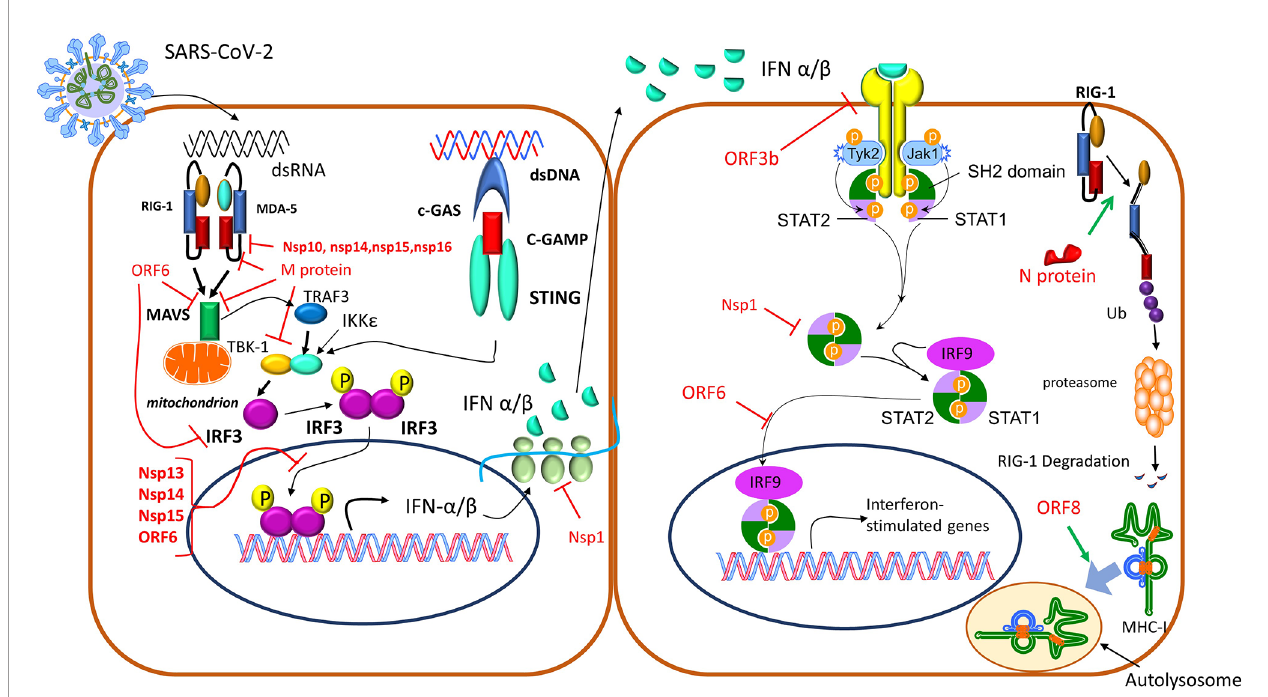
FIGURE 3 | Innate immune detection of SARS-CoV-2 results in the production of interferons, cytokines and chemokines (35). Innate immune cells detect SARS-CoV-2 via different mechanisms/pathways. (A) Viral RNA activates the MyD88 – NF-kB and IRF pathways inducing production of in fl ammatory cytokines and type I interferons. Additionally, the cGAS – STING and the MDA-5/RIG-I pathways, also sense the cytoplasmic viral RNA or viral replicative intermediates, and lead to the production of type I and III interferons (IFNa/ b and IFN l ). In turn, these interferons, acting in an autocrine/paracrine way via the IFNAR1/2 or IFNAR2/IL10R pathways, induce the expression of ISGs. (B) PRRs like TLR4 also recognize PAMPs-DAMPs released by damaged cells and induce the production of in fl ammatory cytokines through the NF-kB pathway (36). ASC, apoptosis-associated speck-like protein containing a CARD; cGAMP, cyclic GMP-AMP; cGAS, cyclic GMP-AMP Synthase; DAMPs, damage-associated molecular patterns; IFN, interferon; IFNAR, interferon receptor; IKK, inhibitor of NFkB; IRAK , IL-1R associated kinase; IL10R,interleukin-10 receptor; IRF, interferon regulatory factor; ISGs, interferon-stimulated genes; Jak, Janus kinase; MAVS, mitochondrial antiviral-signaling protein; MD2, myeloid differentiation factor 2; MDA-5, melanoma differentiation-associated gene 5; MyD88, Myeloid differentiation primary response 88; NEMO, NFkB essential modulator; NF-kB, nuclear factor kappa B; PAMPs, pathogen-associated molecular patterns; PRRs, Pattern Recognition Receptors; RIG-I, retinoid inducible gene I; STAT, Signal transducer and activator of transcription; STING, Stimulator of Interferon Genes; TAB, Mitogen-activated protein kinase kinase binding protein; TAK1, TGF b -activated kinase 1; TBK-1, TANK-binding kinase 1; TIRAP, Toll-interleukin 1 receptor (TIR) domain containing adaptor protein; TLR4, Toll-like receptor 4; TRAM, Translocating chain-associated membrane protein; TRAF, TNF receptor-associated factor; TRIF, TIR-domain-containing adapter-inducing interferon- b ; Tyk,